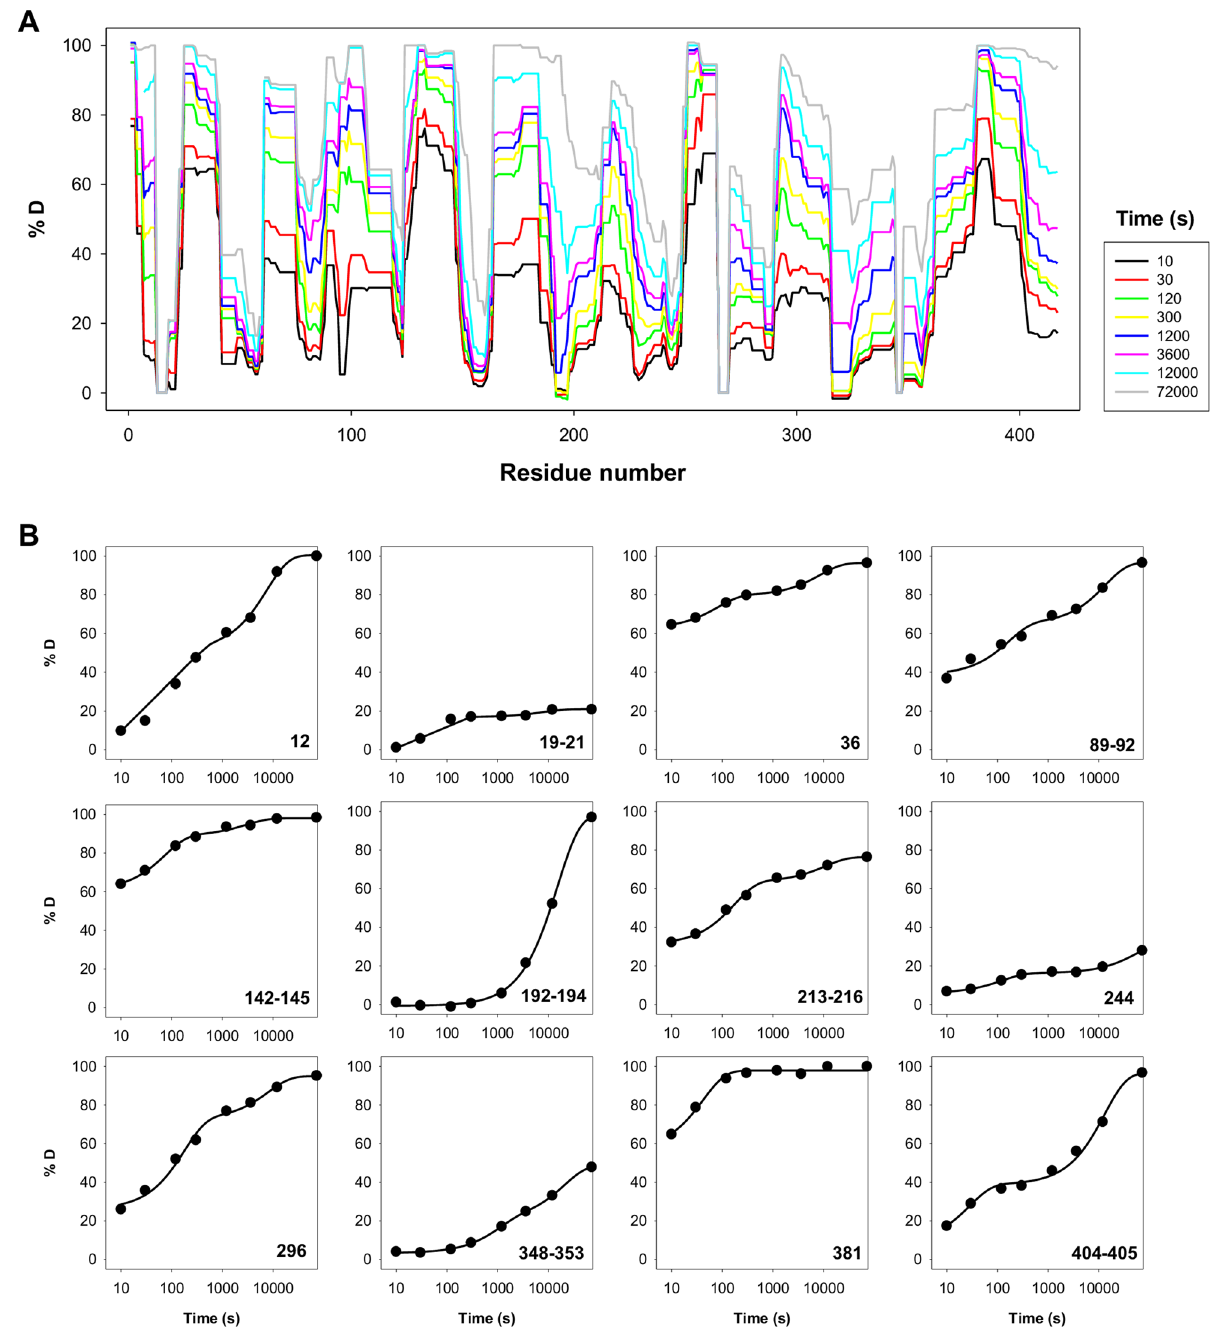
Figure 7. Kinetics of deuterium (D) incorporation to hPGK1 WT. ( A ) % of D incorporation at different time points for the entire hPGK1 protein. Note that segments 13–17, 265–269 and 345–347 were not detected. ( B ) Selected segments displaying complex kinetics. Lines generally show best-fits to a double-exponential function including a burst phases. The best-fit parameters are compiled in Table 5. Experiments were carried out in 20 mM HEPES–NaOH, 200 mM NaCl, 0.5 mM TCEP, pD 7.4 at 25